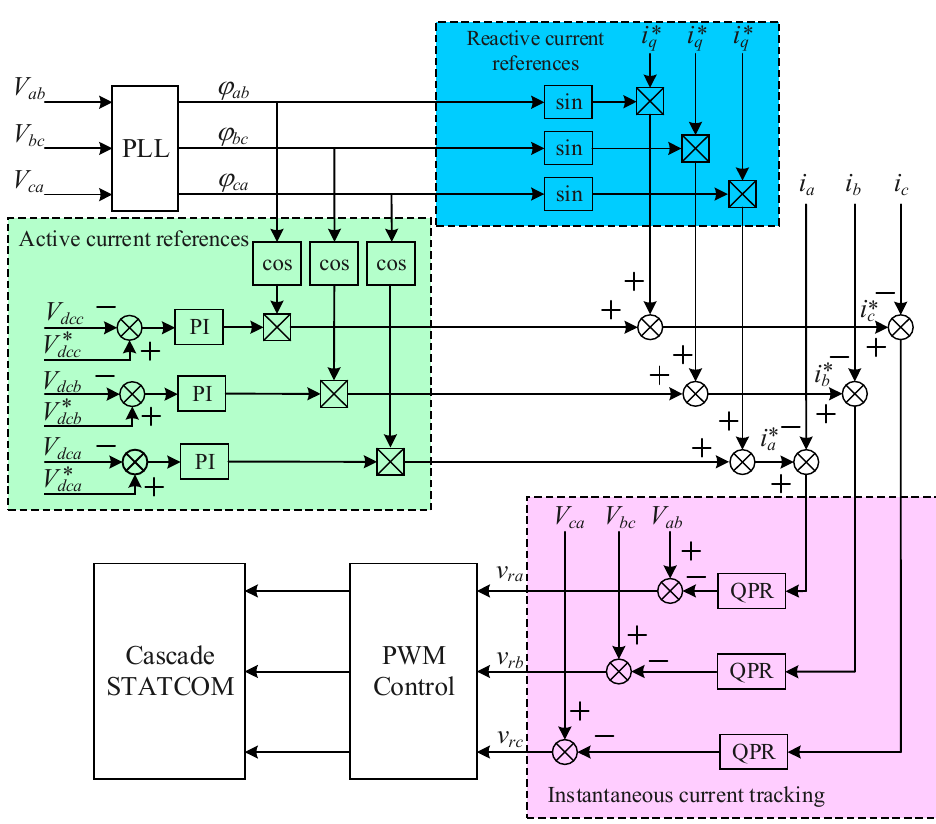
Figure 10. Control strategy of cascade multilevel static synchronous compensator (STATCOM).